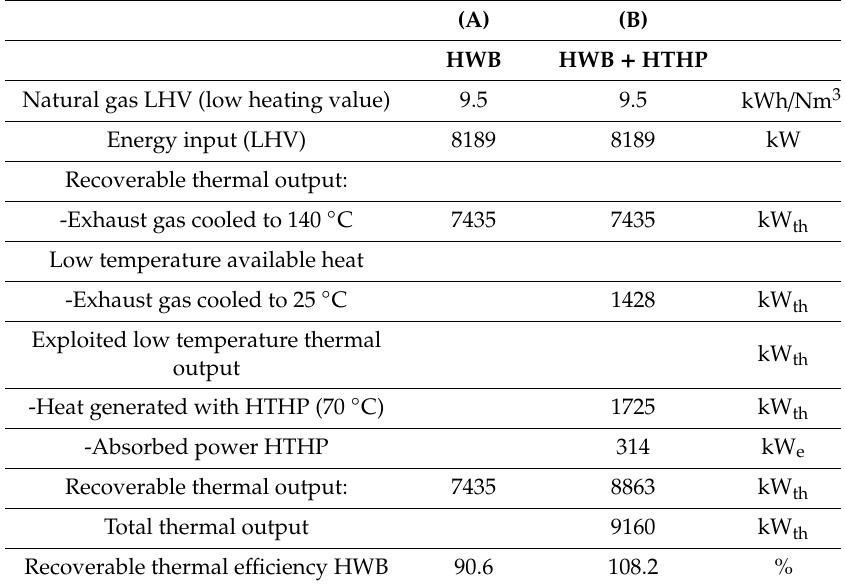
Figure 3. The obtained quantity of condensate with an additional cooling of the flue gases HWB. Table 1. (A) technical data by the manufacturer of the hot water boiler operating at 100% and (B) technical data utilization of low-temperature sources hot water boiler (HWB) by high-temperature heat pumps